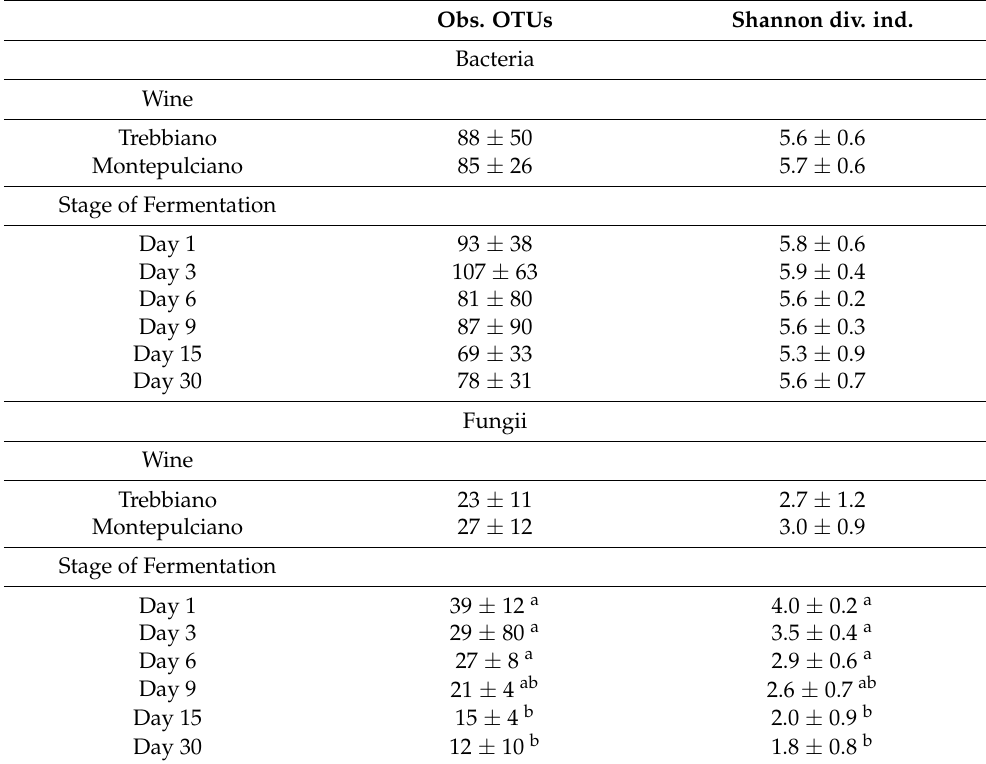
Table 3. Observed OTUs (Obs. OTUs) and Shannon diversity index (Shannon div. ind.) for bacteria and yeast in different wines and at different days of the fermentation progression. Results are shown as mean ± SD. For a given wine and day of fermentation, bacteria and fungi Observed OTUs and Shannon diversity index values with a and b superscripts are significantly different ( p < 0.05). When superscripts were not presented, no significant difference was